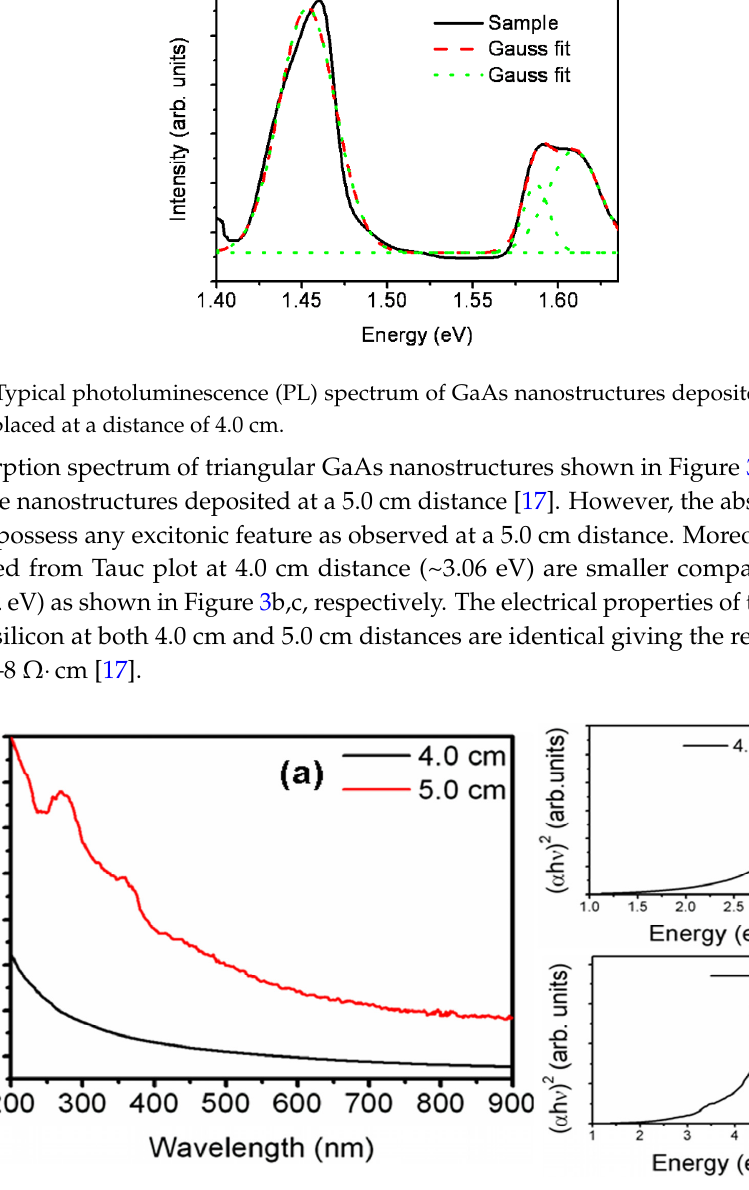
Figure 3. ( a ) Absorption spectra of GaAs nanostructures deposited on silicon substrate placed at a distance of 4.0 cm and 5.0 cm. Tauc plot showing band gap for ( b ) 4.0 cm, ( c ) 5.0 cm distances.